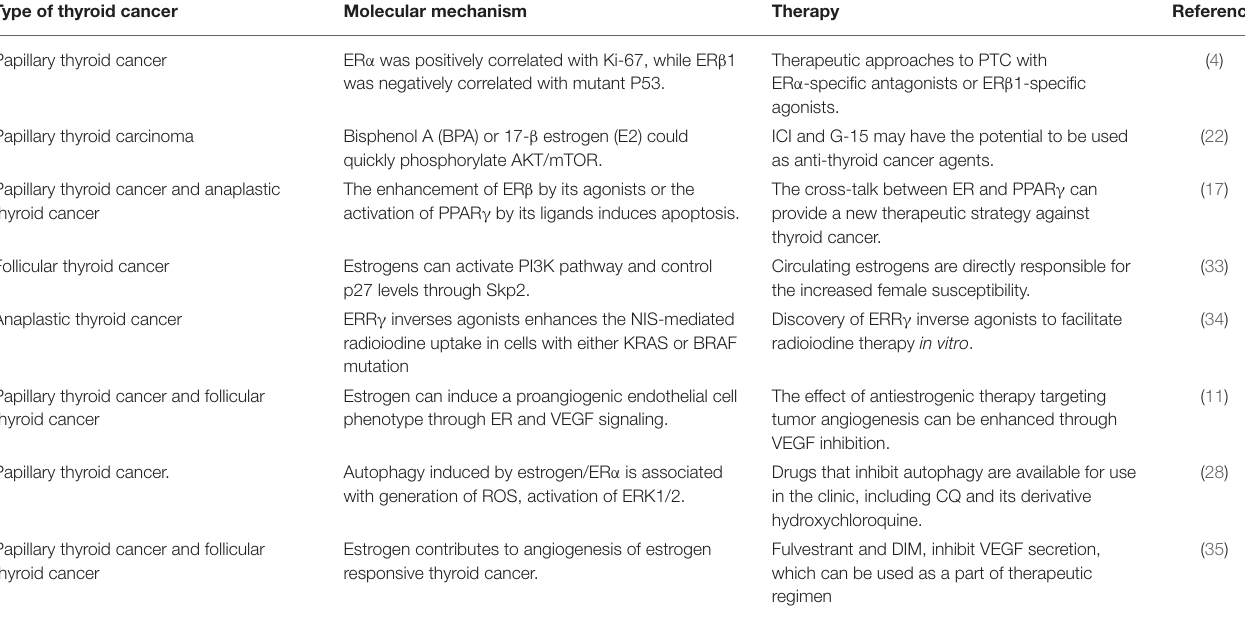
TABLE 3 | Novel therapies for different types of thyroid